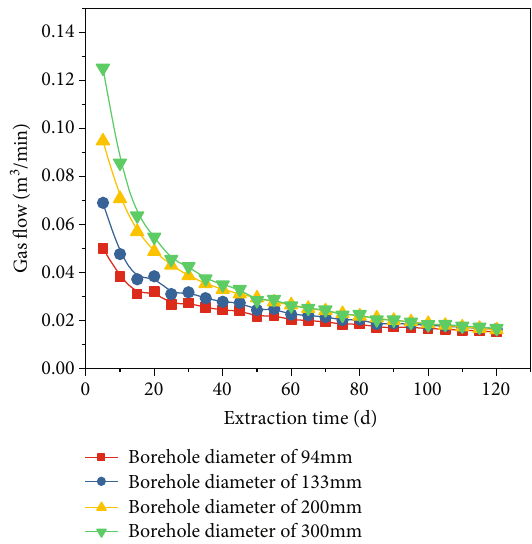
Figure 17: Variation of gas fl ow under di ff erent borehole diameters.